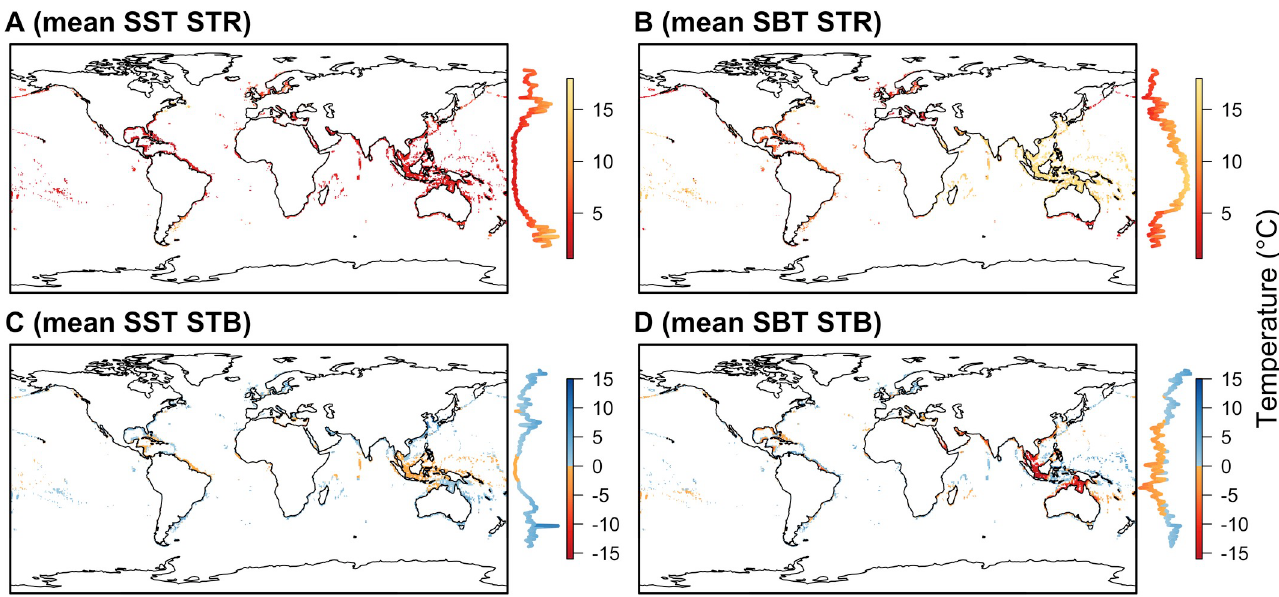
Fig 2. Spatial variation in species’ sensitivity to temperature change within Exclusive Economic Zones. A, B, The mean species’ thermal range (STR) across all species in each cell derived from (A) sea surface temperature (SST) and (B) sea bottom temperature (SBT). C, D, The mean species’ thermal bias (STB) derived from (C) SST and (D) SBT. Adjacent to each map, the coloured line shows the mean STR or STB across all cells in each latitudinal band, following same colour scheme as for the map. Background coastline data are from Natural Earth (public